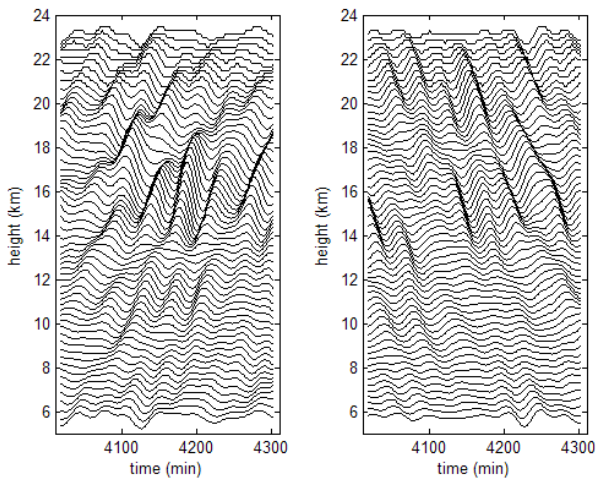
Fig.A1 Partial profile of winter zonal perturbation velocity obtained from Window- Fig. A1. Partial profile of winter zonal perturbation velocity ob- T2Z3: Data contributed by phase-upward waves was shown in the left panel, tained from Window- T2Z3: Data contributed by phase-upward and data contributed by phase-downward waves was shown in the right panel. waves was shown in the left panel, and data contributed by phase- downward waves was shown in the right